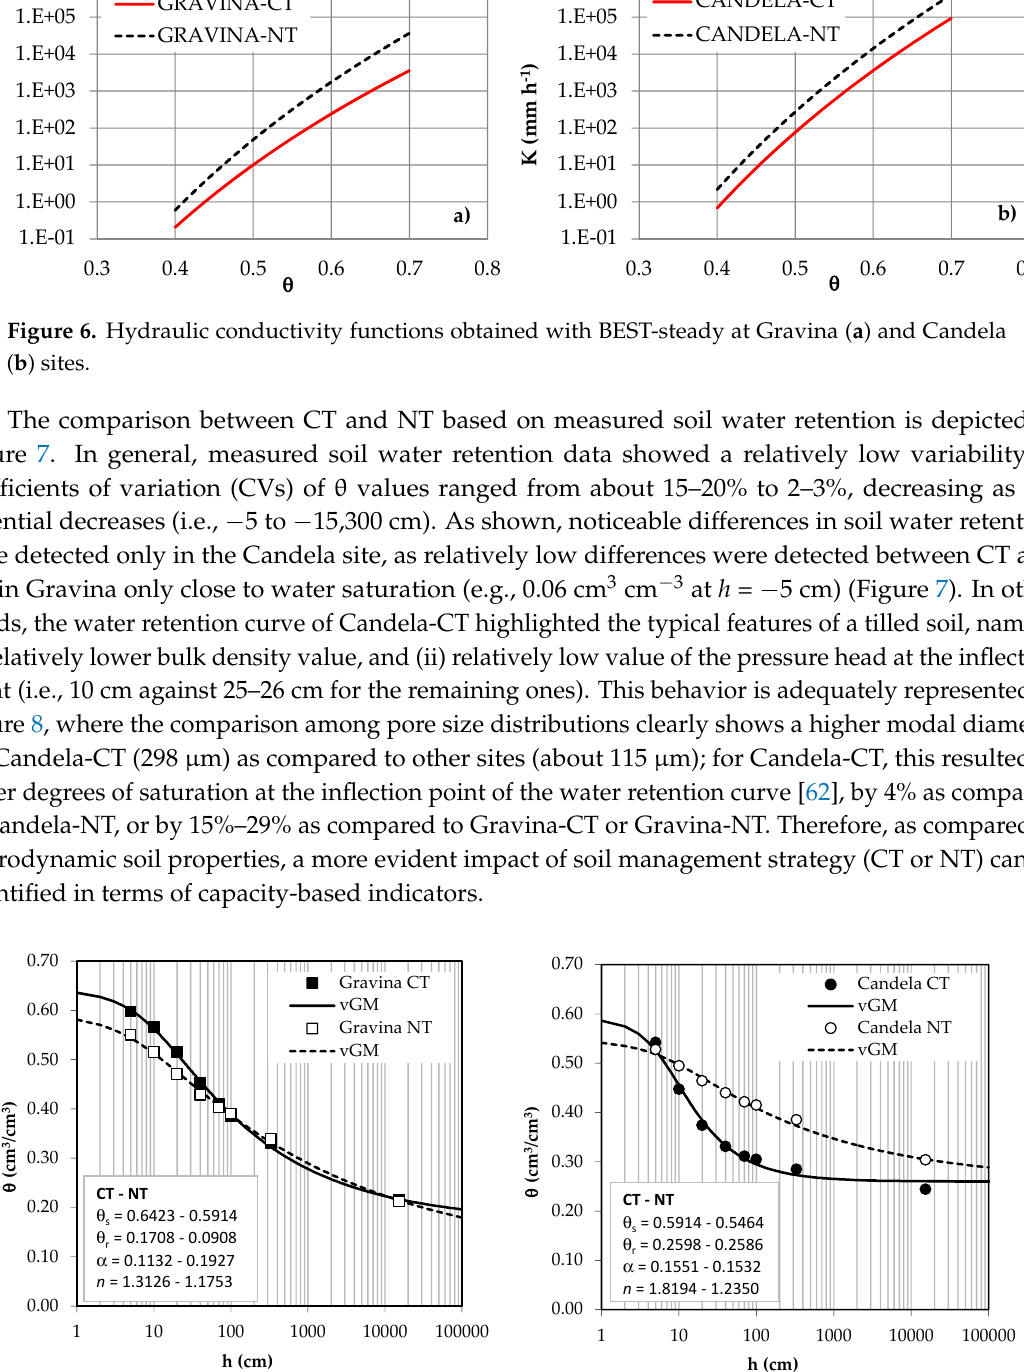
Figure 7. Measured (points) and modelled (lines) soil water retention data (van Genuchten model, vGM) for conventional tillage (CT) and no-tillage (NT) of Gravina (on the left) and Candela (on the right) sites. Parameters of vGM ( θ s , θ r , α , and n ) are also reported ( α = 1/cm).